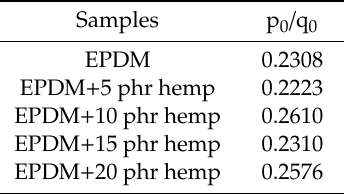
Table 3. Compositional characteristics, designation and p 0 / q 0 ratio for EPDM and EPDM / hemp samples.